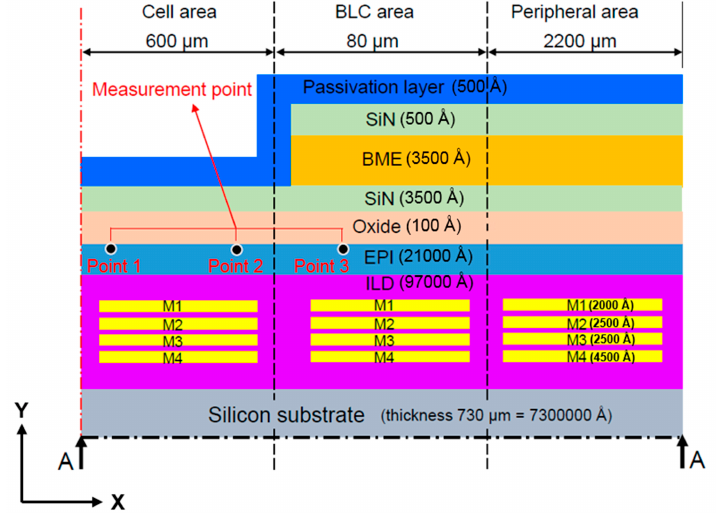
Figure 2. Side view (x-y plane) of Structure A showing a section of the stacked-film architecture along the line A–A.